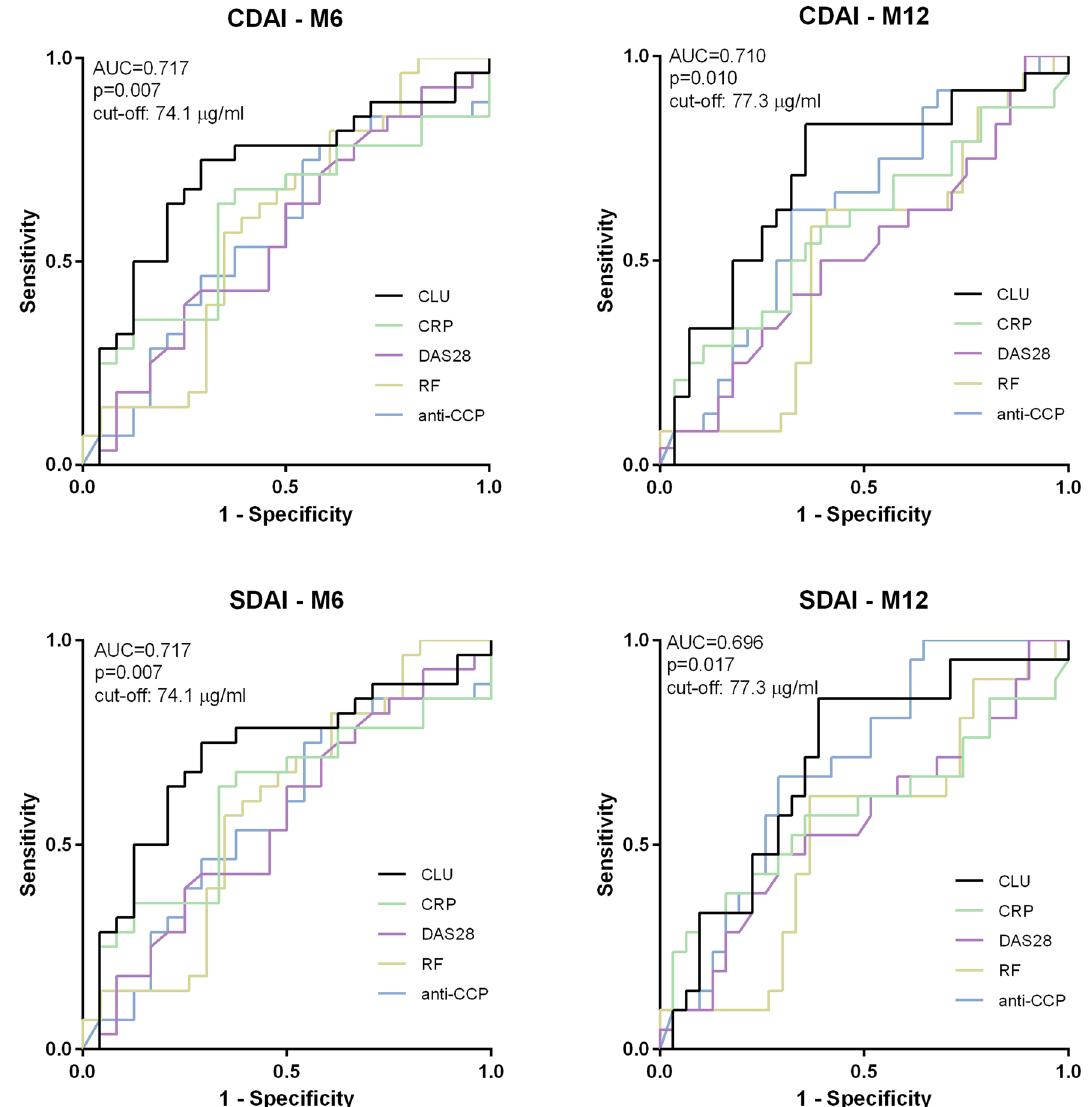
Figure 4. ROC curve analysis of baseline CLU levels, DAS28, RF, anti-CCP and CRP levels for prediction of achieving major treatment response after 6 and 12 months of treatment according to the CDAI and